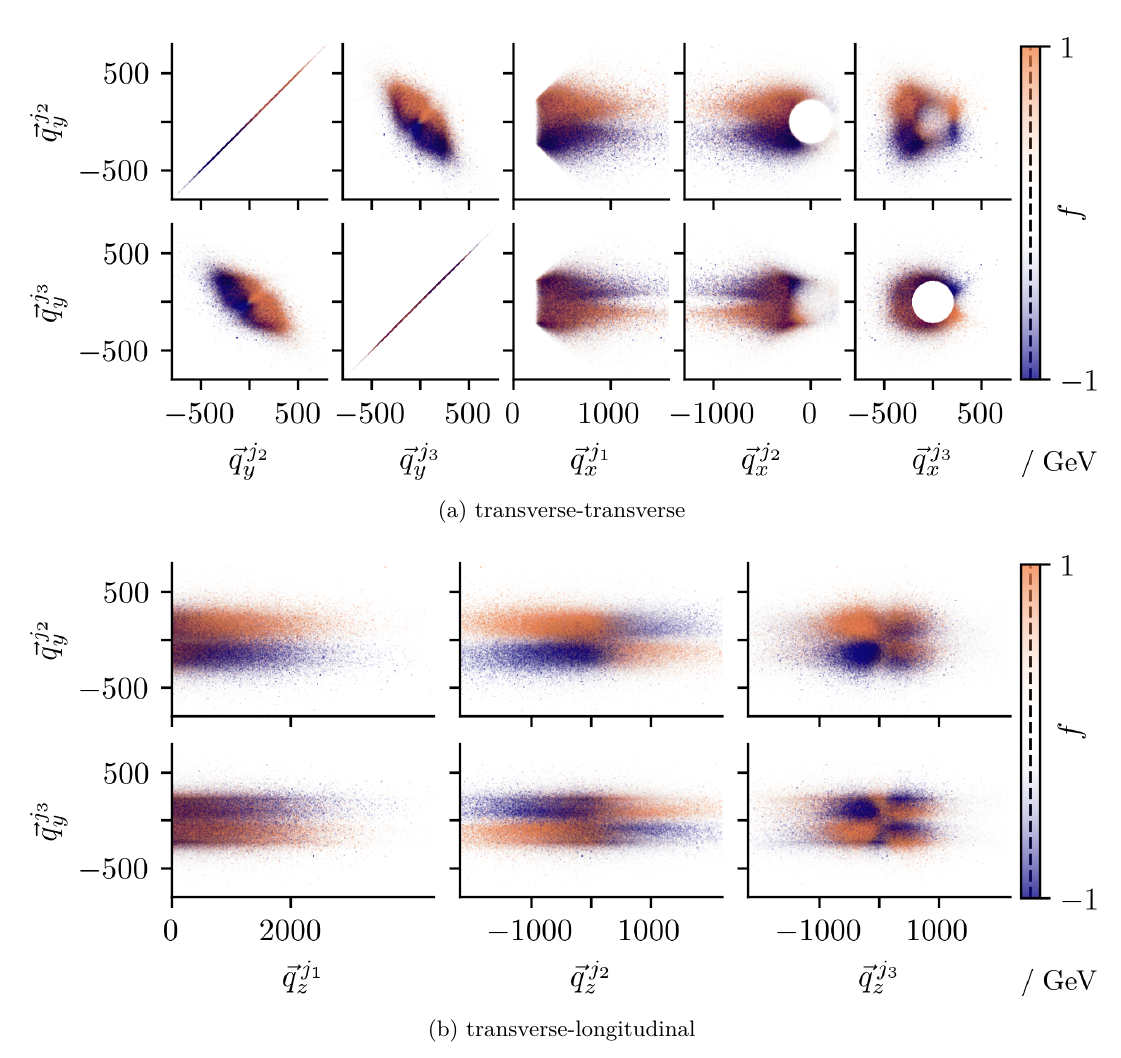
Figure 8 . Kinematic distributions of the parity-odd variable f from the reco-jet NN with λ PV = 1 in the rotation-invariant ~q j i coordinates defined in section 4.1.1. The plots contain one million data a from the testing dataset, scattered with colour and transparency set by the value of f . Although each point has relatively low transparency, overlaid points accumulate to the observed distributions. As seen from figure 6, the vast majority of data have small | f | ; only the most parity-violating phase space is visible here. If the NN is accurate, then colours in blue ( f < 0 ) should have lower density than those in orange ( f > 0 ); as seen, the difference is